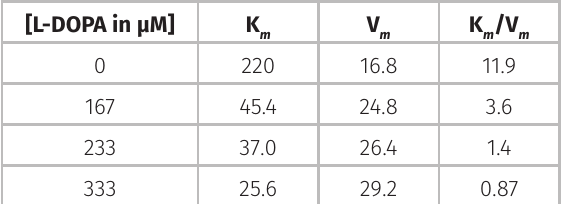
Table II. Michaelis constant and maximum speed for tyrosinase activity in the presence of ±catechins.